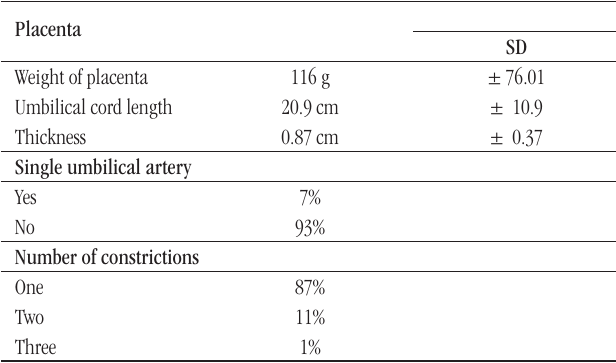
TABLE 1 – Description of the anatomopathological characteristics of the placenta and umbilical